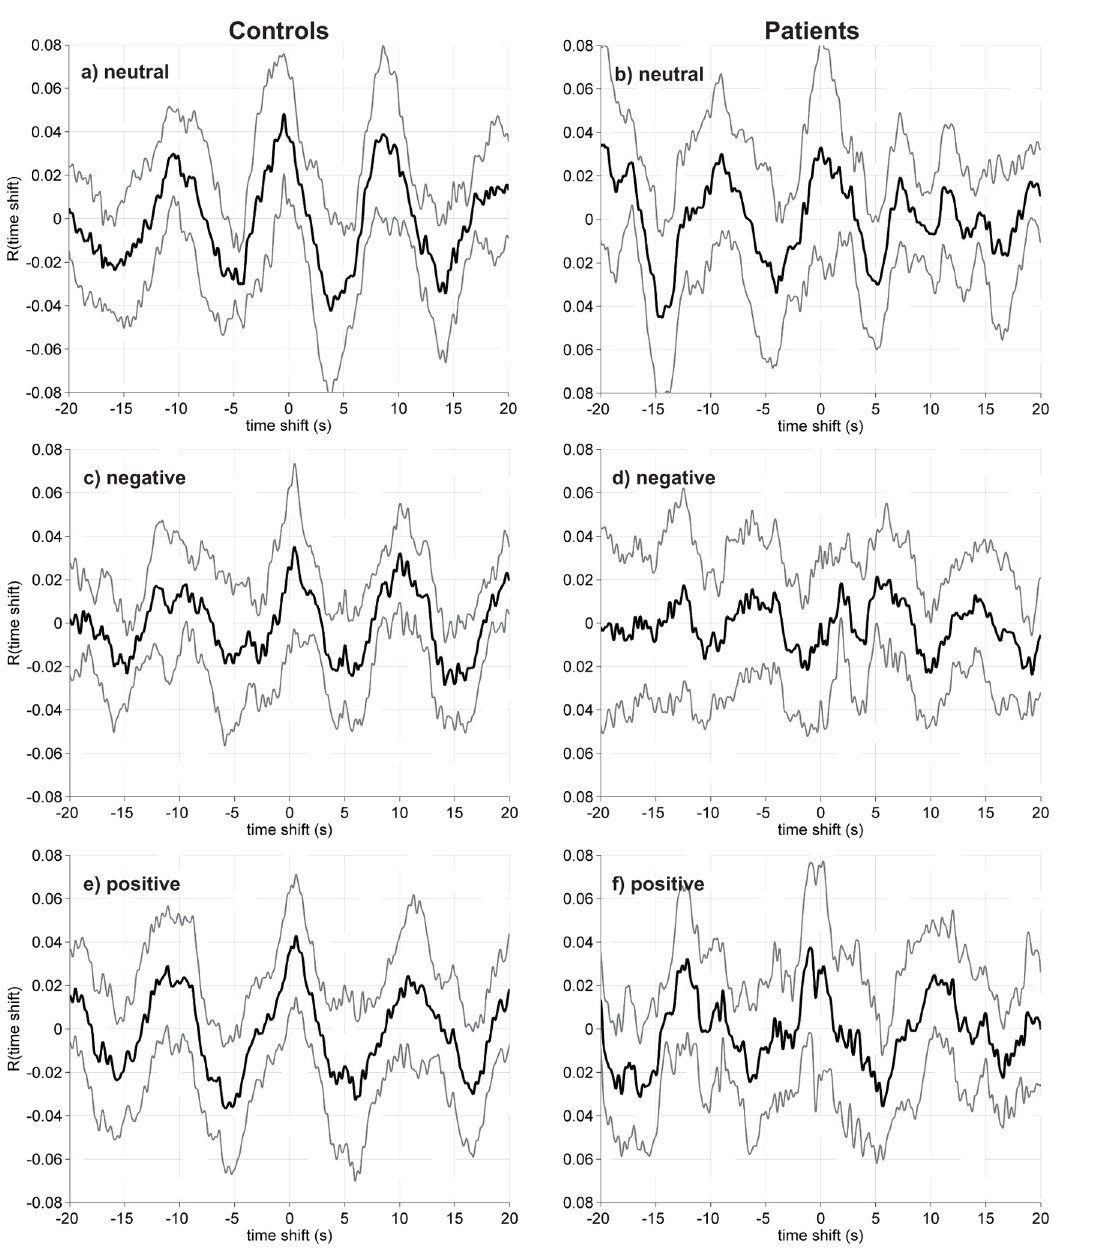
Fig 6. Cross-correlation functions. Mean cross-correlation curves and the 95% confidence intervals (grey lines). The curves to the left shows the control group (n = 14), and the curves to the right shows the patient group (n = 12). a — b) neutral viewing condition, c — d) negative viewing condition, e — f) positive viewing